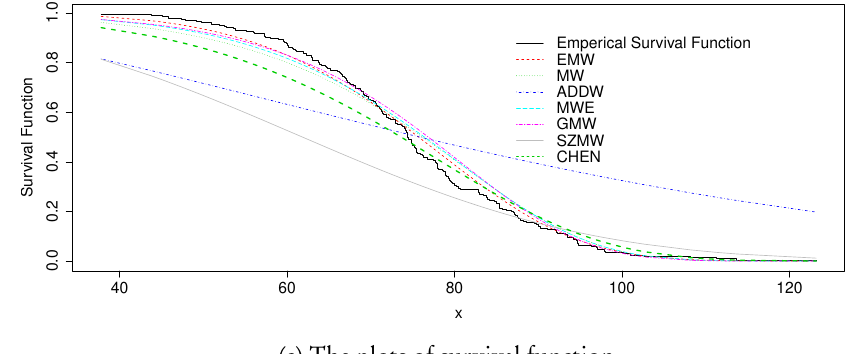
(c) The plots of survival function. Figure 4 – Model fitting plots for